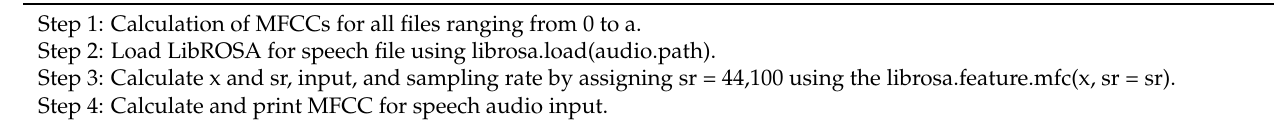
Table 4. Use of LibROSA for loading files and extracting features (MFCC) in the proposed